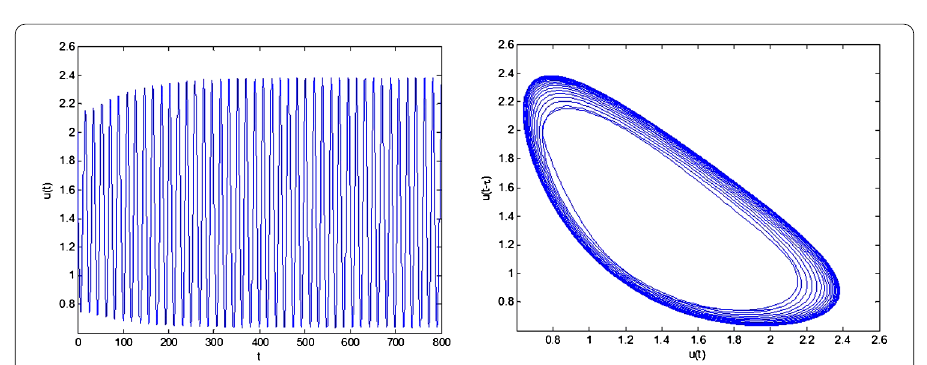
Figure 6 Waveform plot and phase portrait of the controlled fractional-order model (4.2) with α = 0.92, m = 0.2, k p = 0.05, k d = 0.5 and the initial value u 0 = 2. A Hopf bifurcation occurs and the periodic oscillation bifurcates from u ∗ , where υ = 7 > υ c 0 = 6.1794.